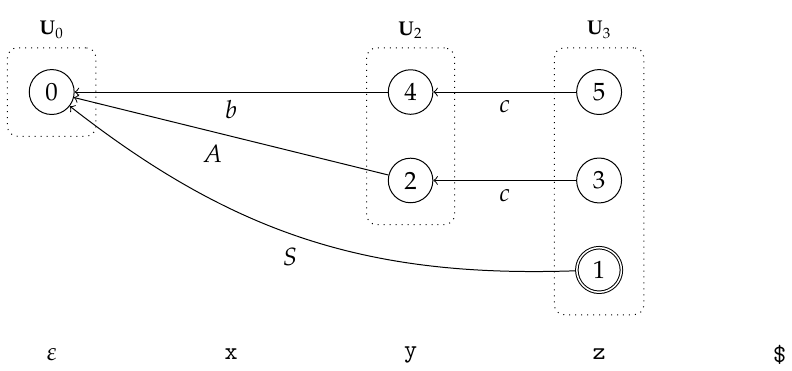
“ M b | M c | M $ for the specification Ξ in (1). $